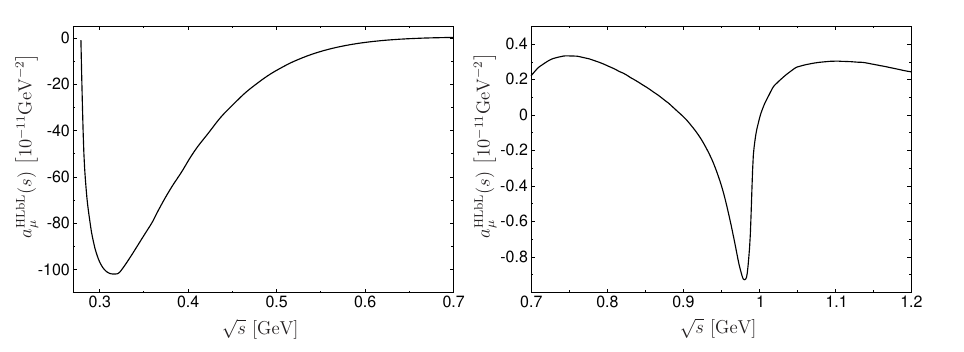
Figure 1. Spectral shape in the f 0 (500) (left) and the f 0 (980) (right) regions, as a function of center-of- mass energy p s ; from Ref. [59]. The integration over s gives the contribution to a HLbL µ Table 1. Estimates for the various contributions to HLbL scattering from WP20 [6], PdRV(09) [50], N / JN(09) [51, 52], J(17) [42]; from Ref. [6].